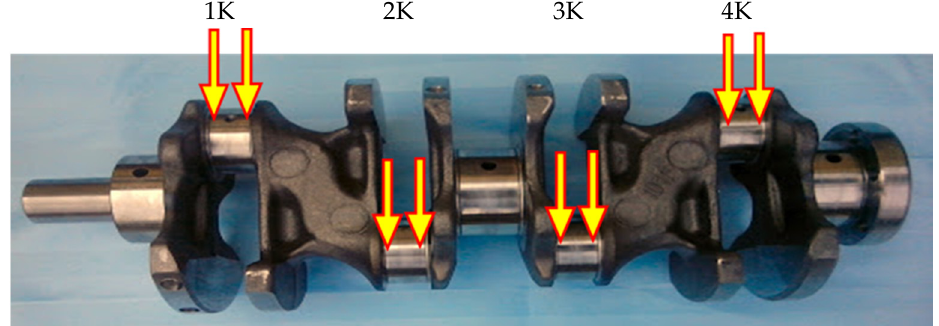
Figure 6. Sampling spots of connecting rod pins (1 cylinder—1K, 2 cylinder—2K, 3 cylinder—3K, 4 cylinder—4K).